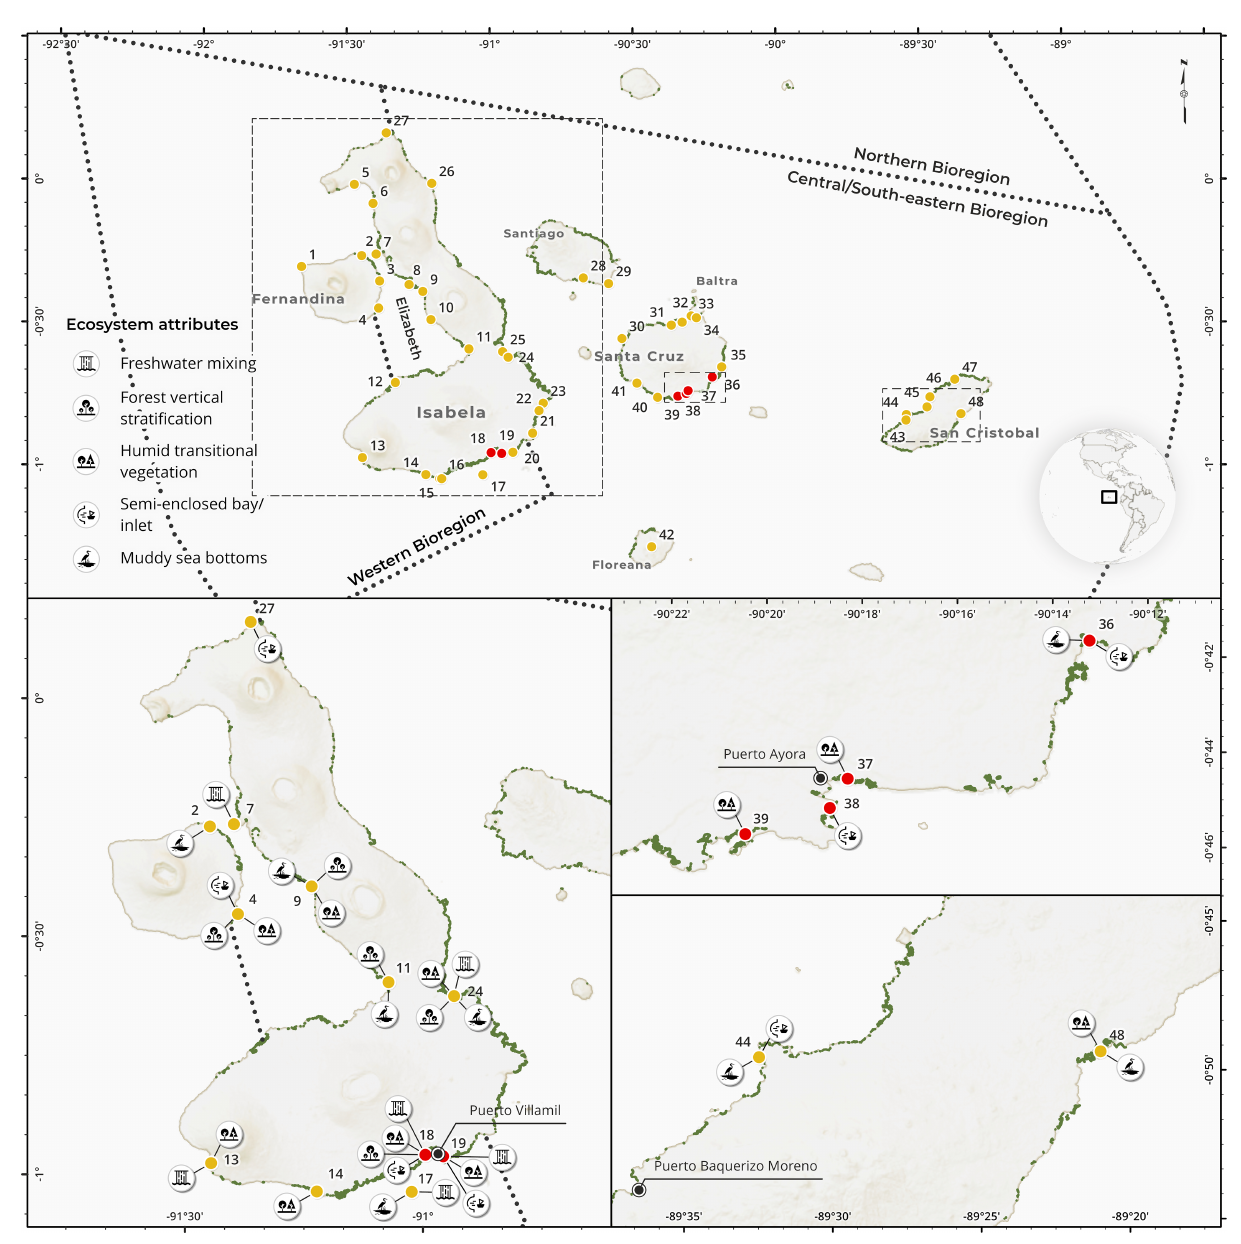
FIGURE 4 | Upper panel. Map of the Galapagos Islands showing ‘ important ’ mangrove sites (yellow circles) identi fi ed by artisanal fi shers during interviews. Green polygons along the coast represent mangrove vegetation, as mapped in Moity et al. (2019). Marine bioregions de fi ned by Moity (2019) are overlaid in the map. Site names were number-coded and can be found in Table S9 . Lower panels. Subsets maps of Isabela, Santa Cruz and San Cristobal contrasting ‘ important ’ and ‘ impacted ’ sites (red circles) regarding ecosystem attributes associated to fi shery productivity. Depicted port villages represent locations in which interviews were